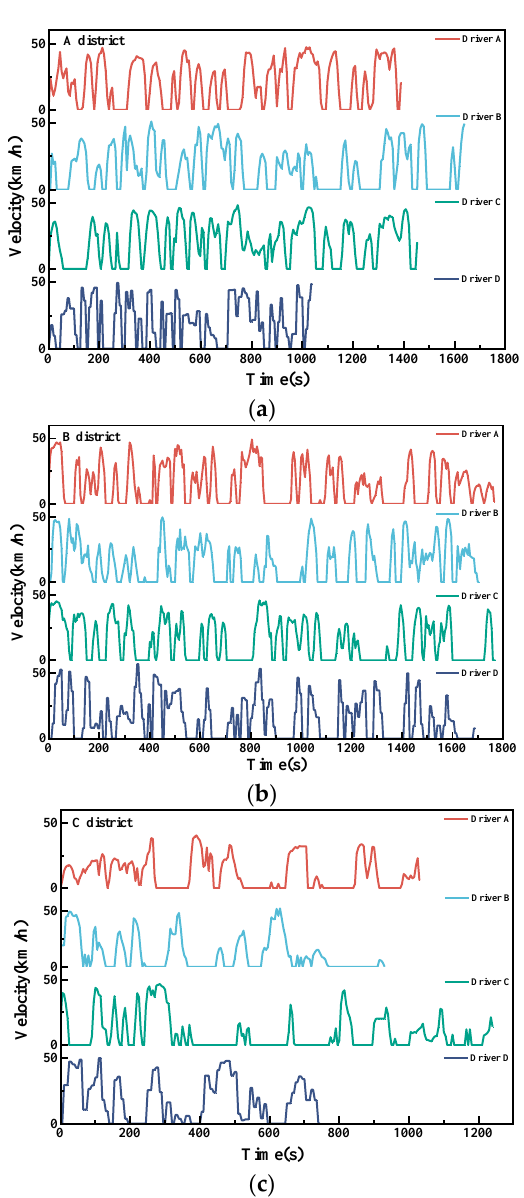
Figure 11. Driving cycle velocity of different drivers in ( a ) A district; ( b ) B district; ( c ) C district. Based on the information of acceleration, the driving styles are classified as Aggres- sive and Gentle. Rapid acceleration and deceleration indicate aggressive driving behavior; smooth acceleration and deceleration represent gentle behavior in driving cycle. Analysis of the data reveal that aggressive driving behavior occurs when buses are entering and exiting stations, overtaking and changing lanes. While gentle driving with smooth accel- eration, the buses often run at a constant speed or at low speeds close to idle on crowded roads. Classification of vehicle driving styles is usually based on driver and occupant comfort, and an acceleration of 2 m/s 2 is used as a boundary to determine whether a driver is driving aggressively. However, for buses with high center of gravity and high carriage, a very small acceleration in their driving can cause large roll angle. Therefore, it is scien- tific to classify bus driving styles with acceleration values smaller than those of the car. Classification of bus driving styles by acceleration values is shown in Table 3.